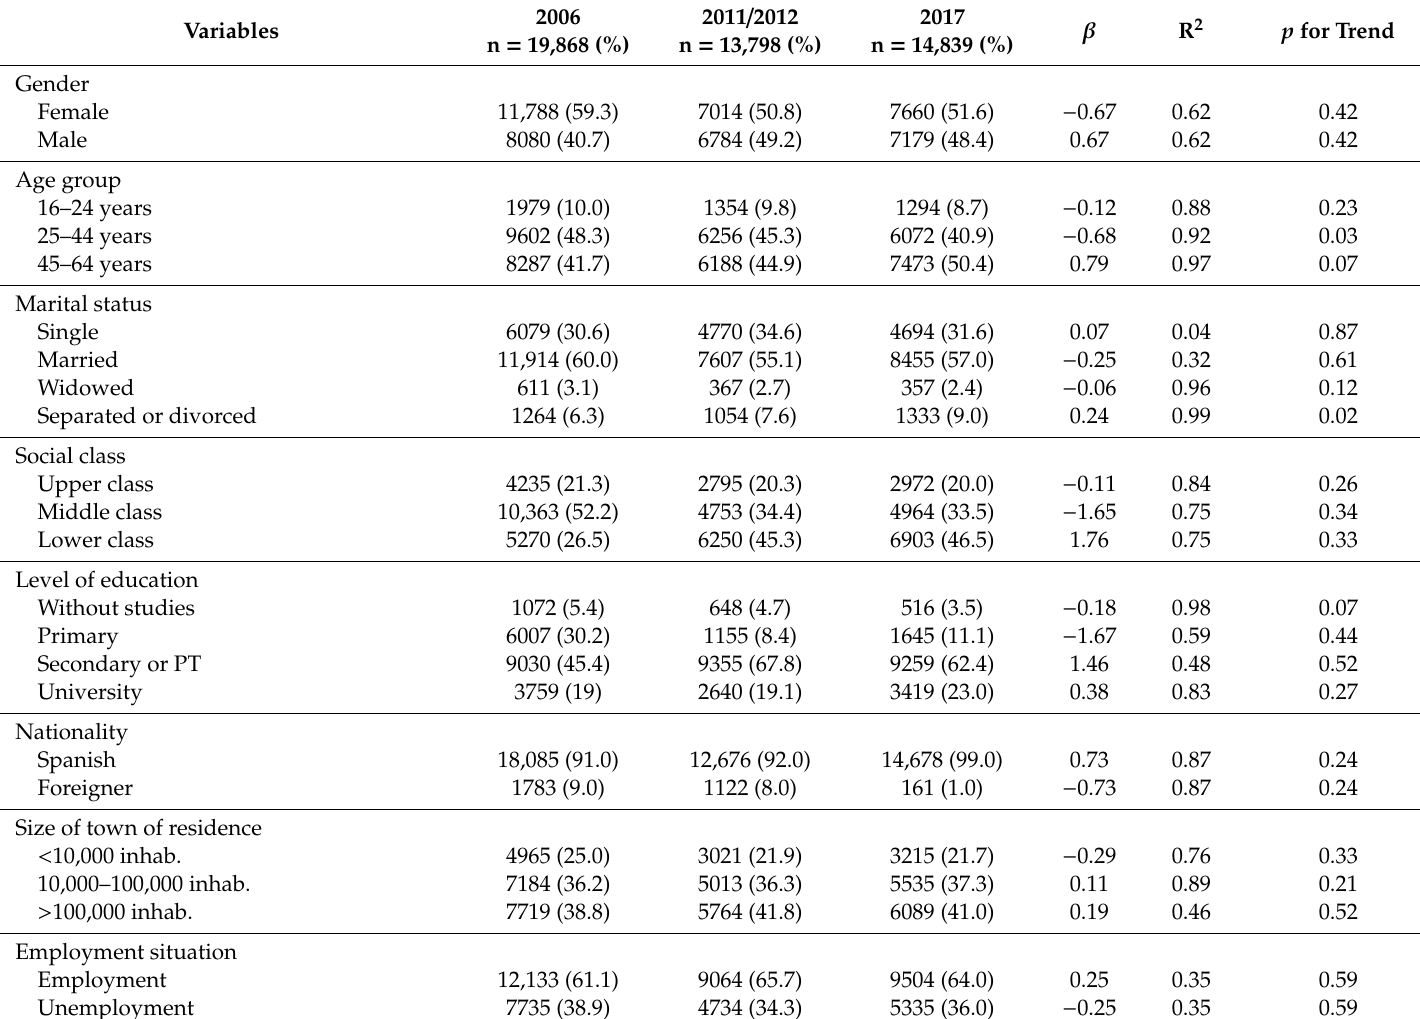
Table 1. Trends for sociodemographic, clinical, lifestyle and environmental variables of people aged from 16 to 64 years in Spain (N = 48,505)